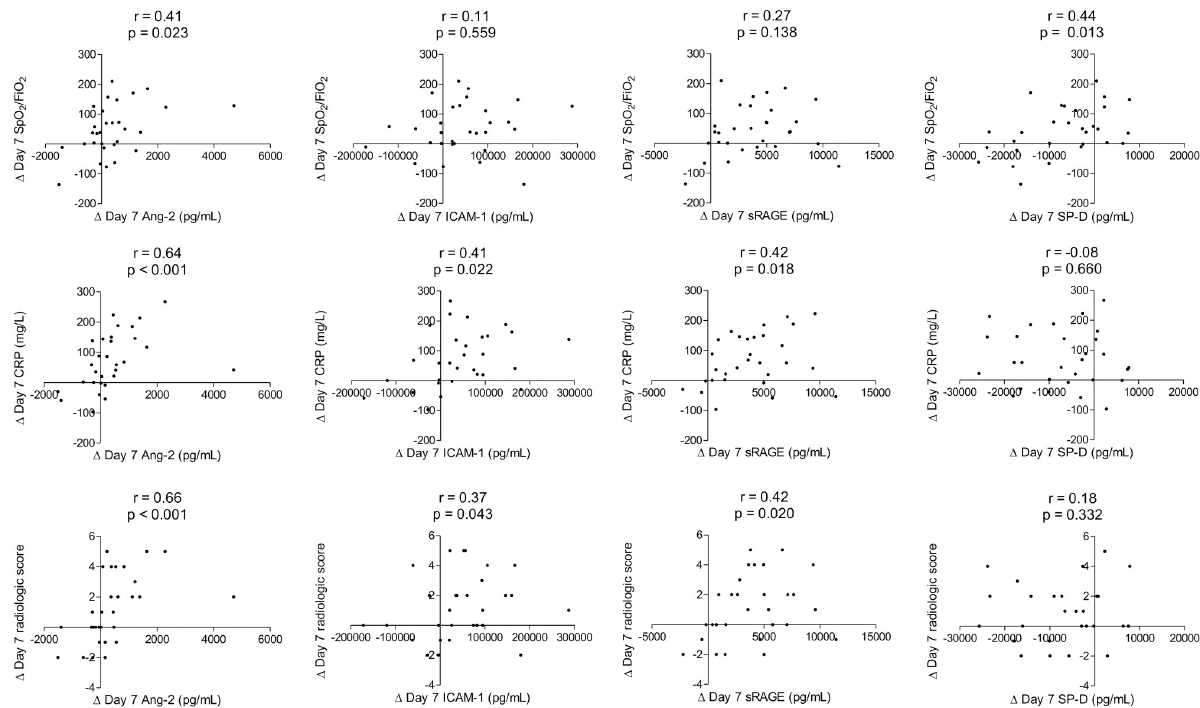
Fig 2. Changes in plasma biomarkers and clinical parameters over the 7-day study period. Ang-2, angiopoietin-2; CRP, C-reactive protein; FiO 2 , fraction of inspired oxygen; ICAM-1, intercellular adhesion molecule-1; SpO 2 , pulse oximetric saturation; sRAGE, soluble receptor for advanced glycation end-products; SP-D, surfactant protein D.